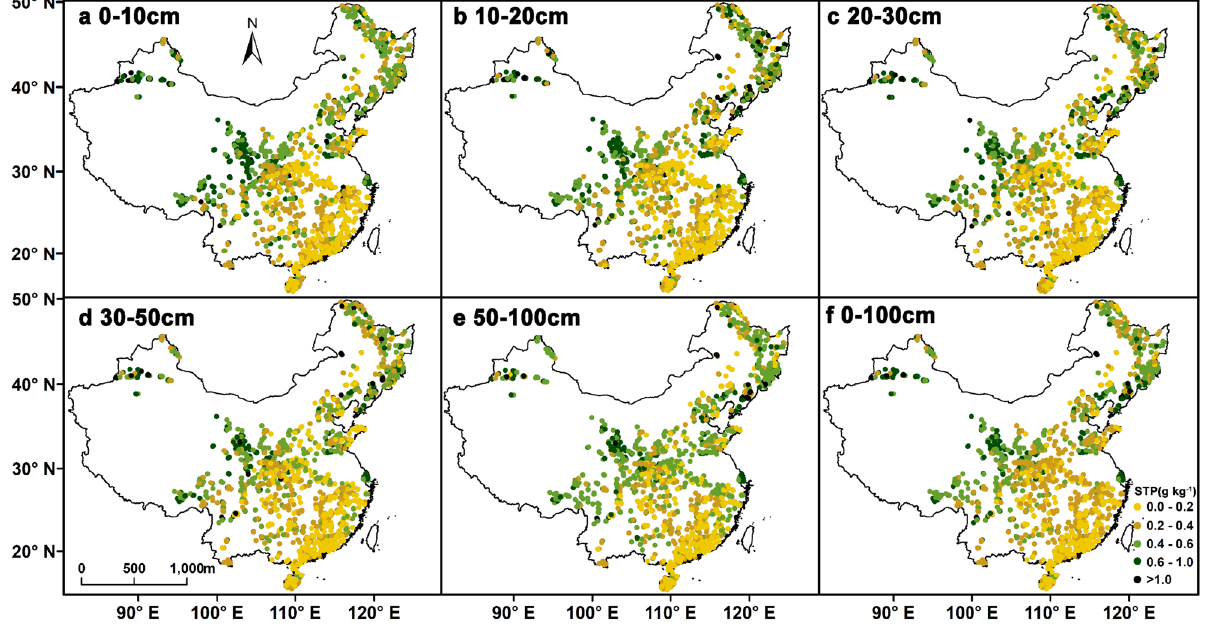
Figure 3. Spatial distribution of soil total P concentrations at different soil depths in China’s forest ecosystems (Map created using ArcGIS 10.6 software by first author, URL: http://www.esri.com).